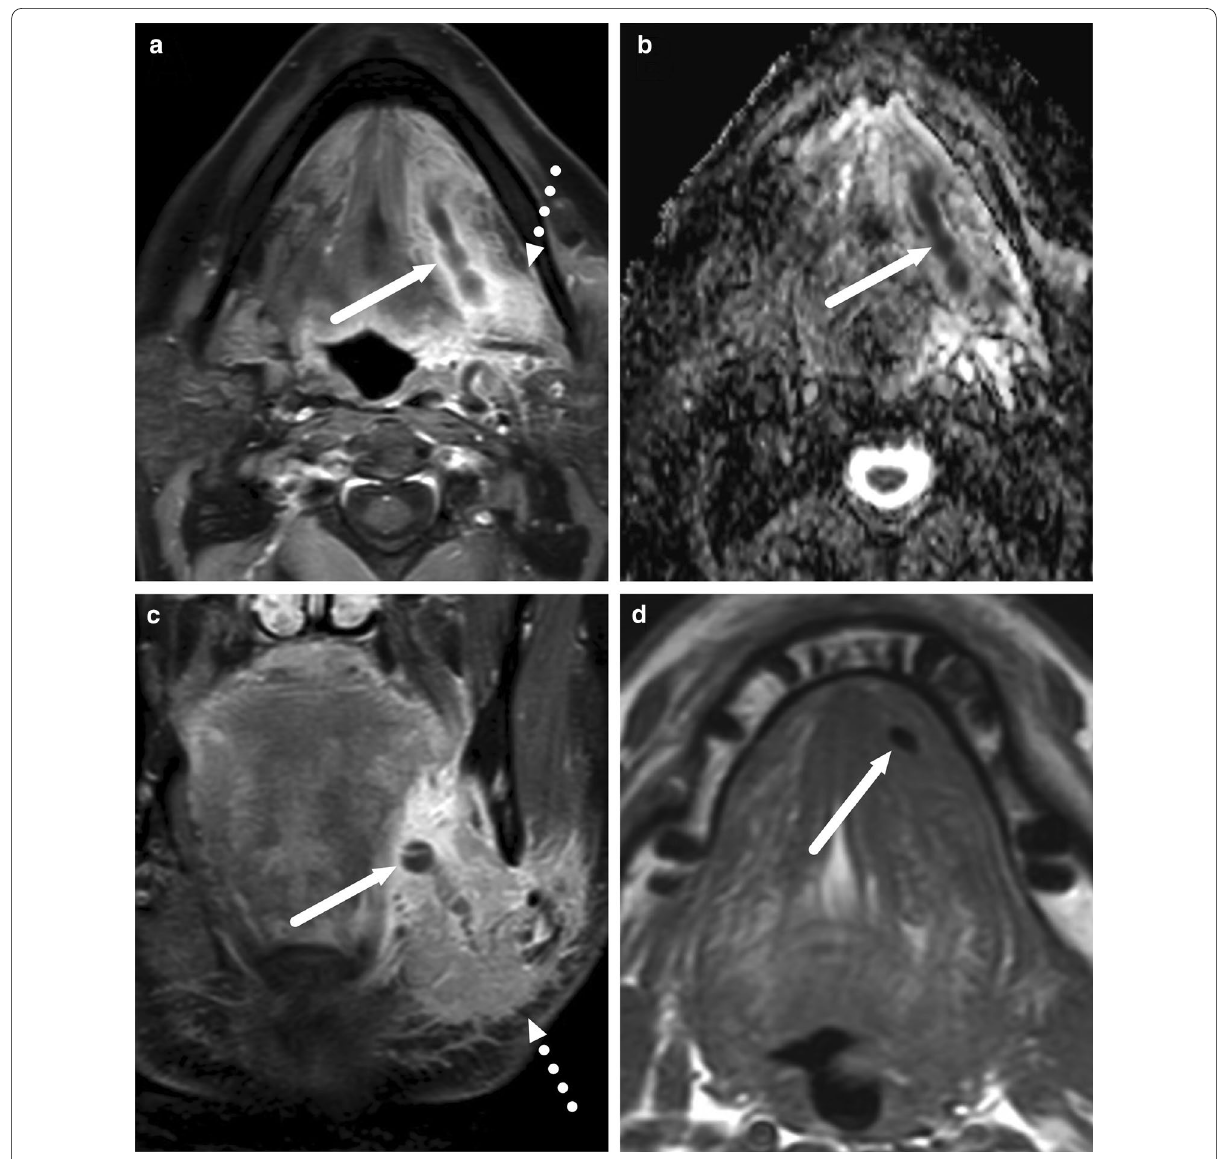
Fig. 23 Purulent obstructive sialadenitis of the submandibular gland. Axial ( a ) and coronal ( c ) post-contrast fat-suppressed T1-weighted images show a dilated submandibular duct (Wharton’s duct) (arrow), and significant edema in and around the gland (dotted arrow). ADC map confirms that the dilated duct is filled with pus (arrow) ( b ), and axial T1-weighted imaging at a level slightly superior shows a sialolith as an ovoid area of signal void (arrow) ( d